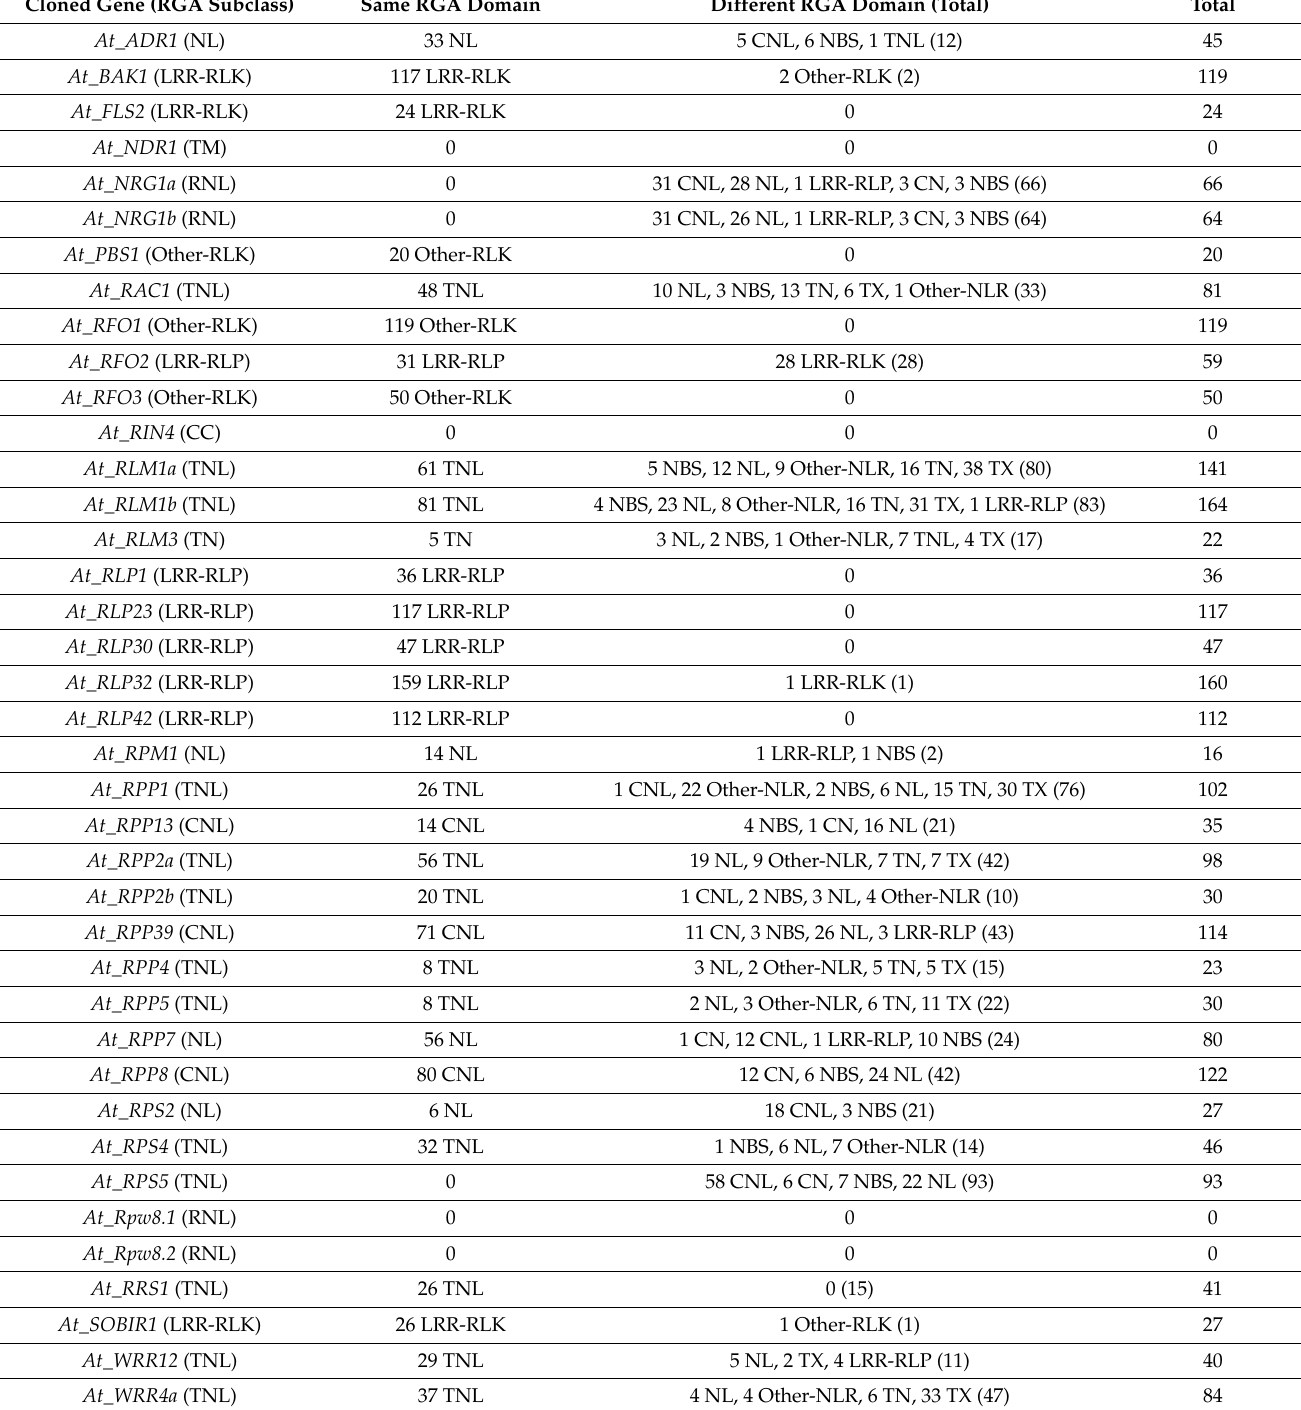
Table 1. Cloned genes with resistance against Brassicaceae diseases and their corresponding homologs (similar by sequence identity) along the homolog types across the 20 studied